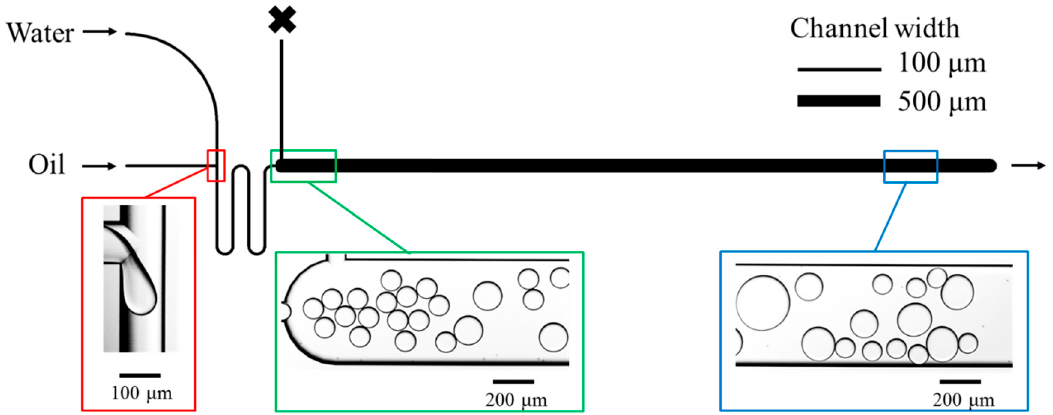
Figure 12. Layout of the microfluidic chip with a T-junction as droplet formation unit (left) a meandering adsorption channel length of 14.8 mm, and a coalescence chamber. The rectangles indicate the regions from which images were recorded and show examples of microscope images [86]. Reprinted with permission from Elsevier.